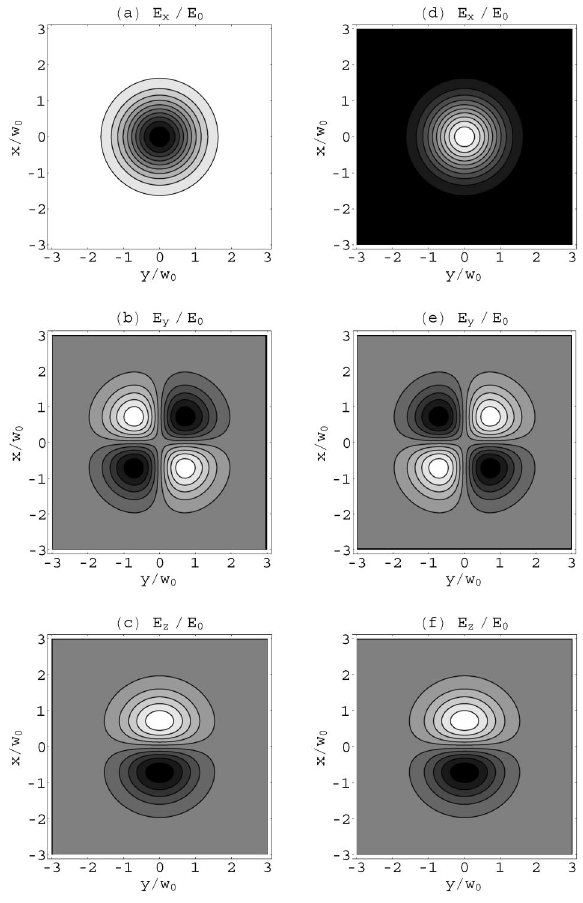
FIG. 3. Contour maps of the electric components of the laser field of a Gaussian beam over a square 30 (cid:28) m on a side, centered at the beam focus and extending in the xy plane. (cid:3) 5 (cid:28) m and (cid:20) (cid:3) 1 : 056 (cid:28) m . In The beam parameters are w 0 (a)–(c) the fields are given at !t (cid:3) 0 , and in (d)–(f) at !t (cid:3) (cid:21)= 2 . Note that positive and negative values are distinguished by the level of shading, dark means negative values and bright positive.